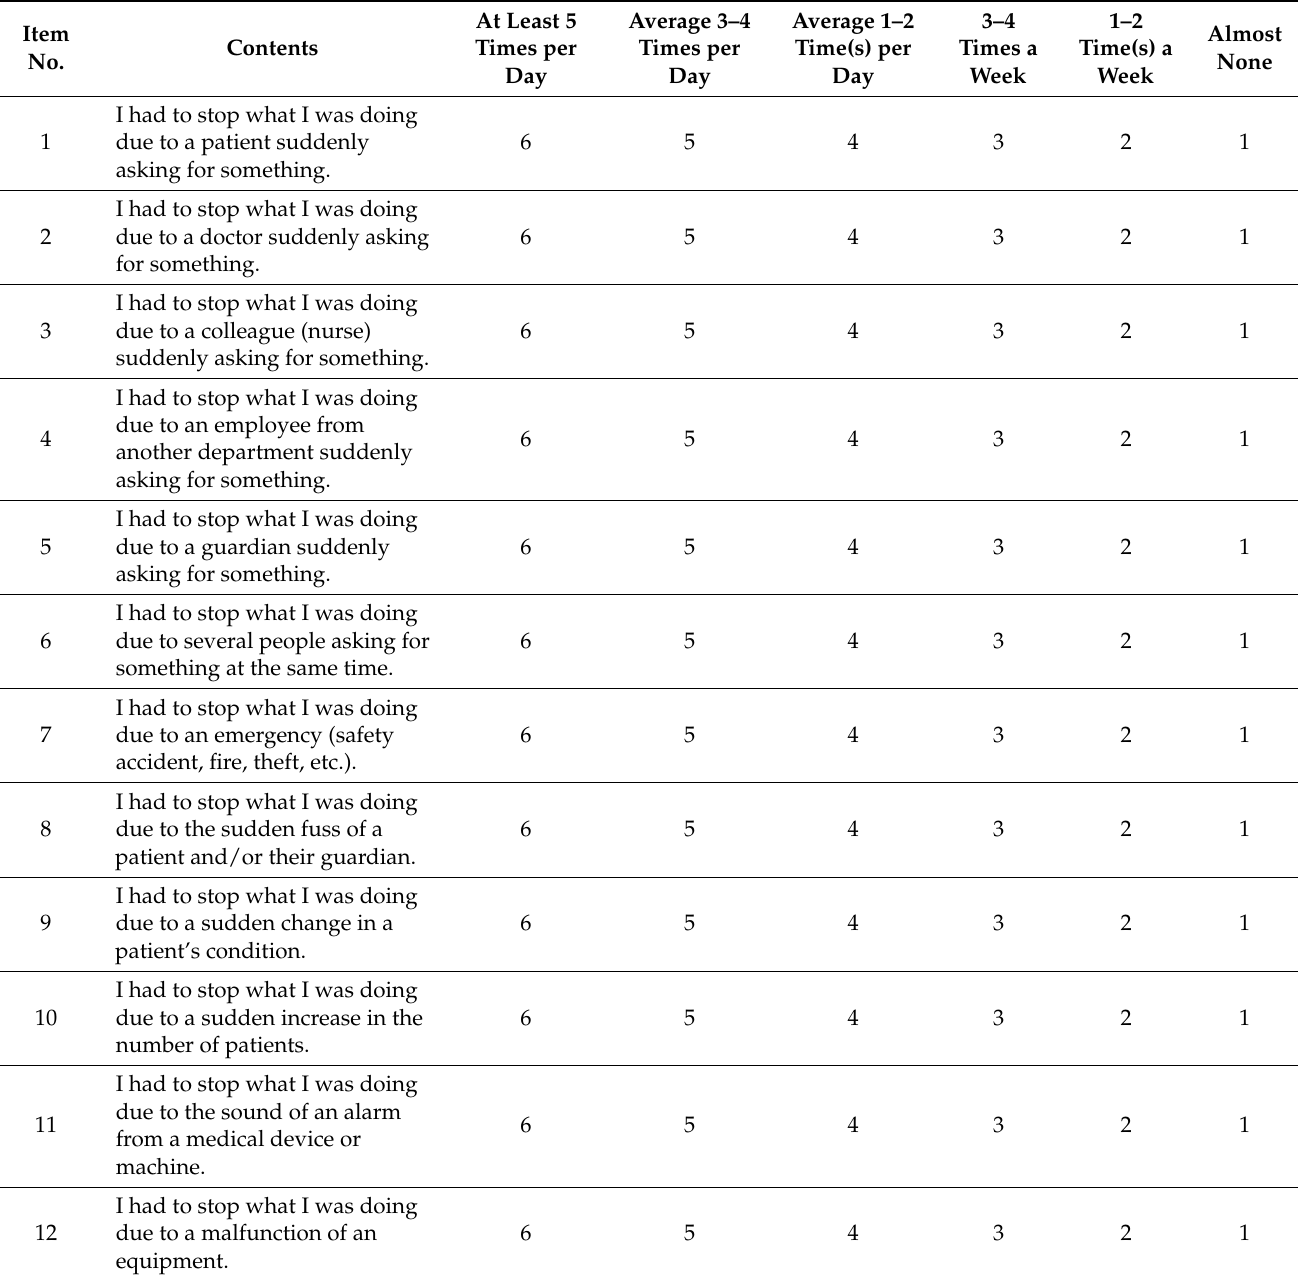
Table 4. The Nursing Work Interruption Scale